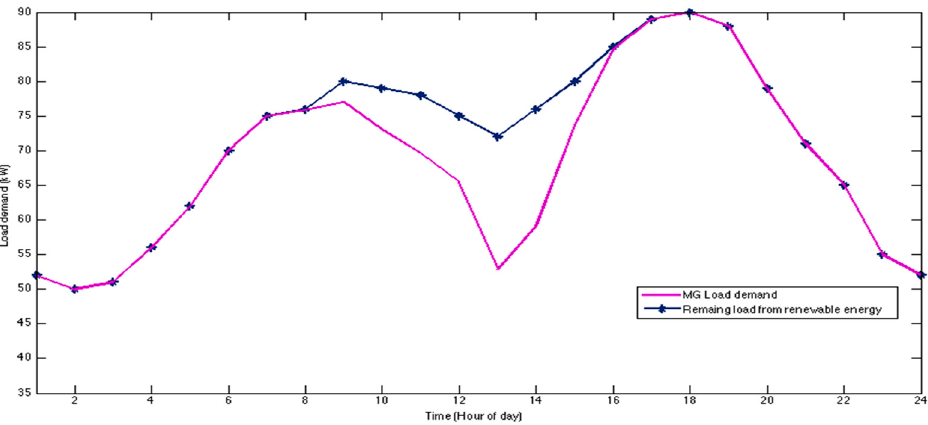
Figure 2. Daily energy consumption before and after renewable energy generation. The optimal power outputs of the MG’s DGs, and also the power purchased/sold to the external